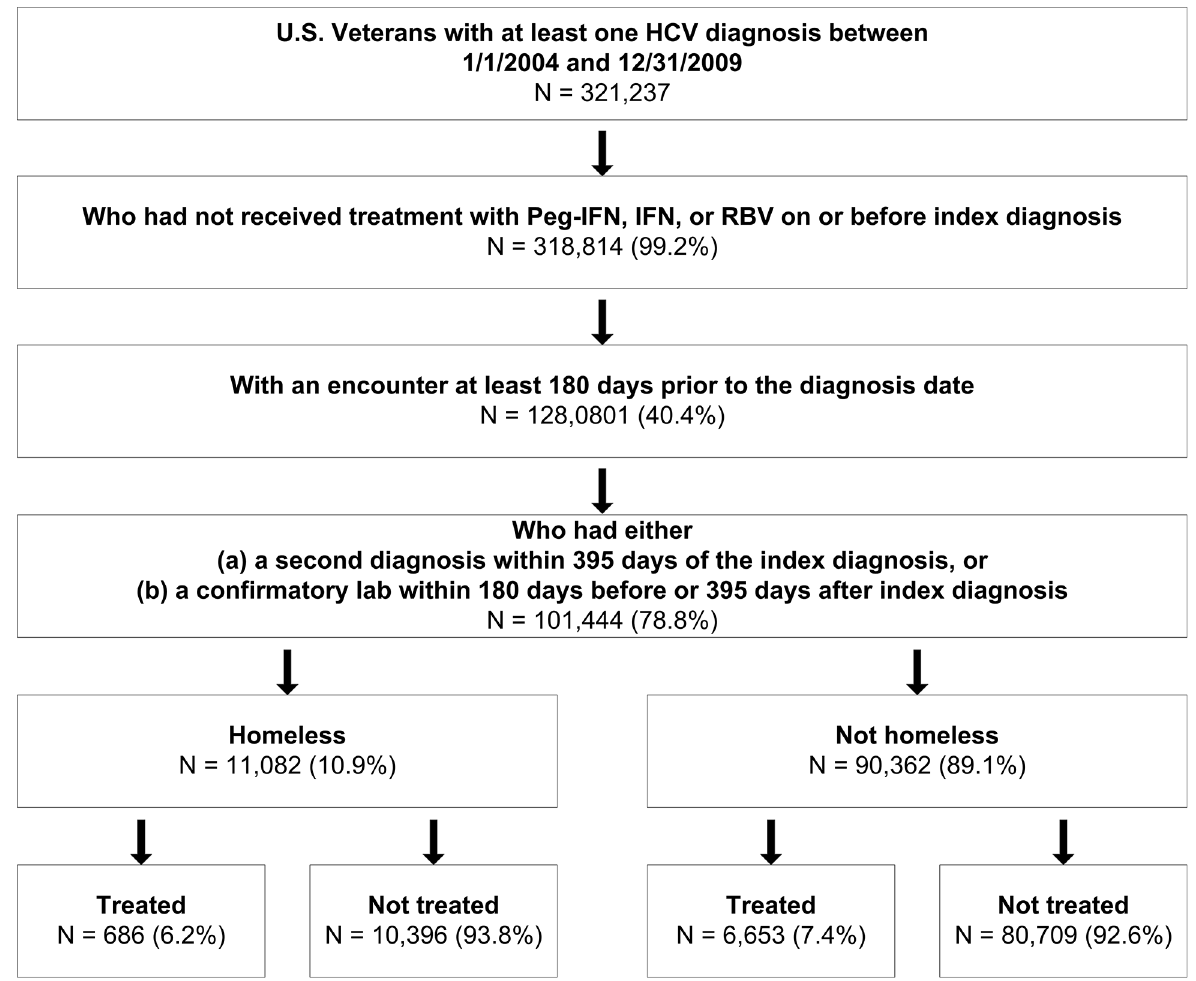
Fig 1. Protocol for identifying HCV positive Veterans who received prescriptions for dual therapy for HCV and their homeless status by administrative indicators, VA medical facilities, 2004 – 2009.